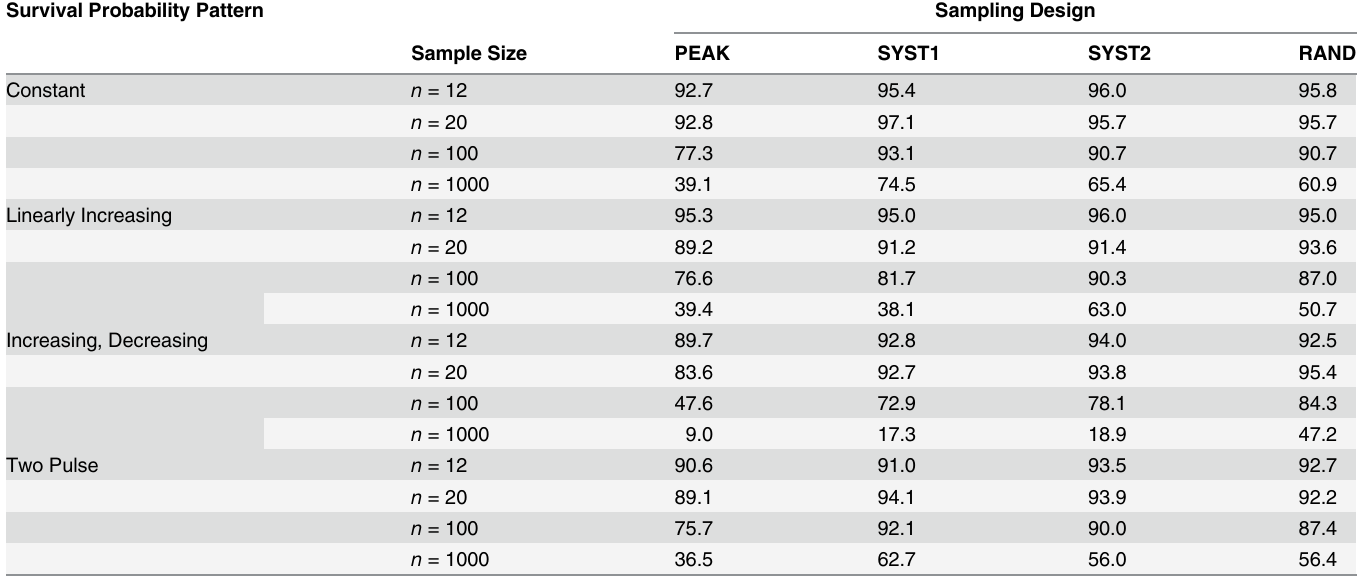
Table 2. Coverage percentages for different survival probability-sampling design combinations using the Wilson interval (nominal coverage is 95%). Survival Probability